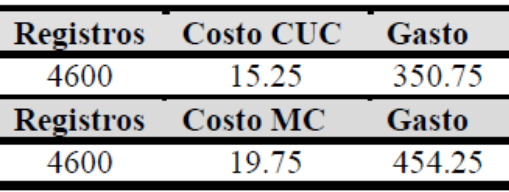
Tabla 1: cálculo de gastos.